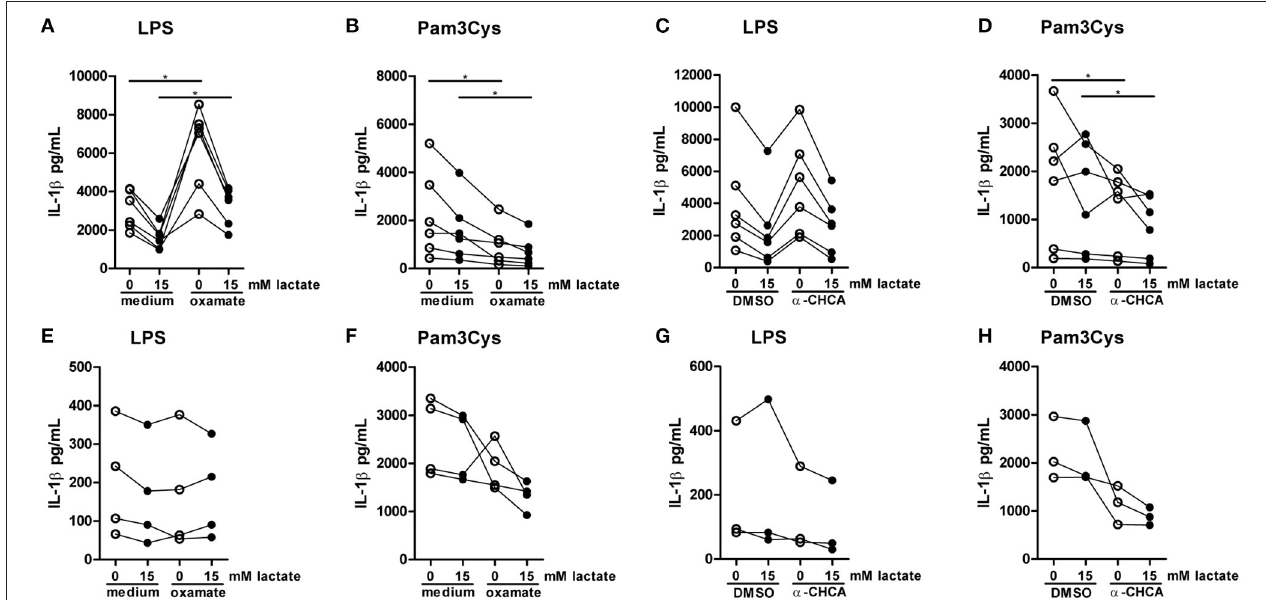
FIGURE 10 | Inhibition of lactate metabolism modulates cytokine production. (A–D) Cytokine production of PBMCs from healthy individuals. PBMCs were pretreated with 40mM sodium oxamate and medium as a control (A,B) or 0.5mM α -cyano-4-hydroxycinnamic acid ( α -CHCA) and DMSO as a control (C,D) for 1h, before first lactate was added for 1h and then LPS (A,C) or Pam3Cys (B,D) was added for 24h. (E–H) Cytokine production of CD14 + monocytes from healthy individuals. Monocytes were pretreated with 40mM sodium oxamate and medium as a control (E–F) or 0.5mM α -CHCA and DMSO as a control (G,H) for 1h, before first lactate was added for 1h and then LPS (E,G) or Pam3Cys (F,H) was added for 24h. (A–D) n = 6, (E,F) n = 4, (G,H) n = 3. * p < 0.05, Wilcoxon signed rank test.